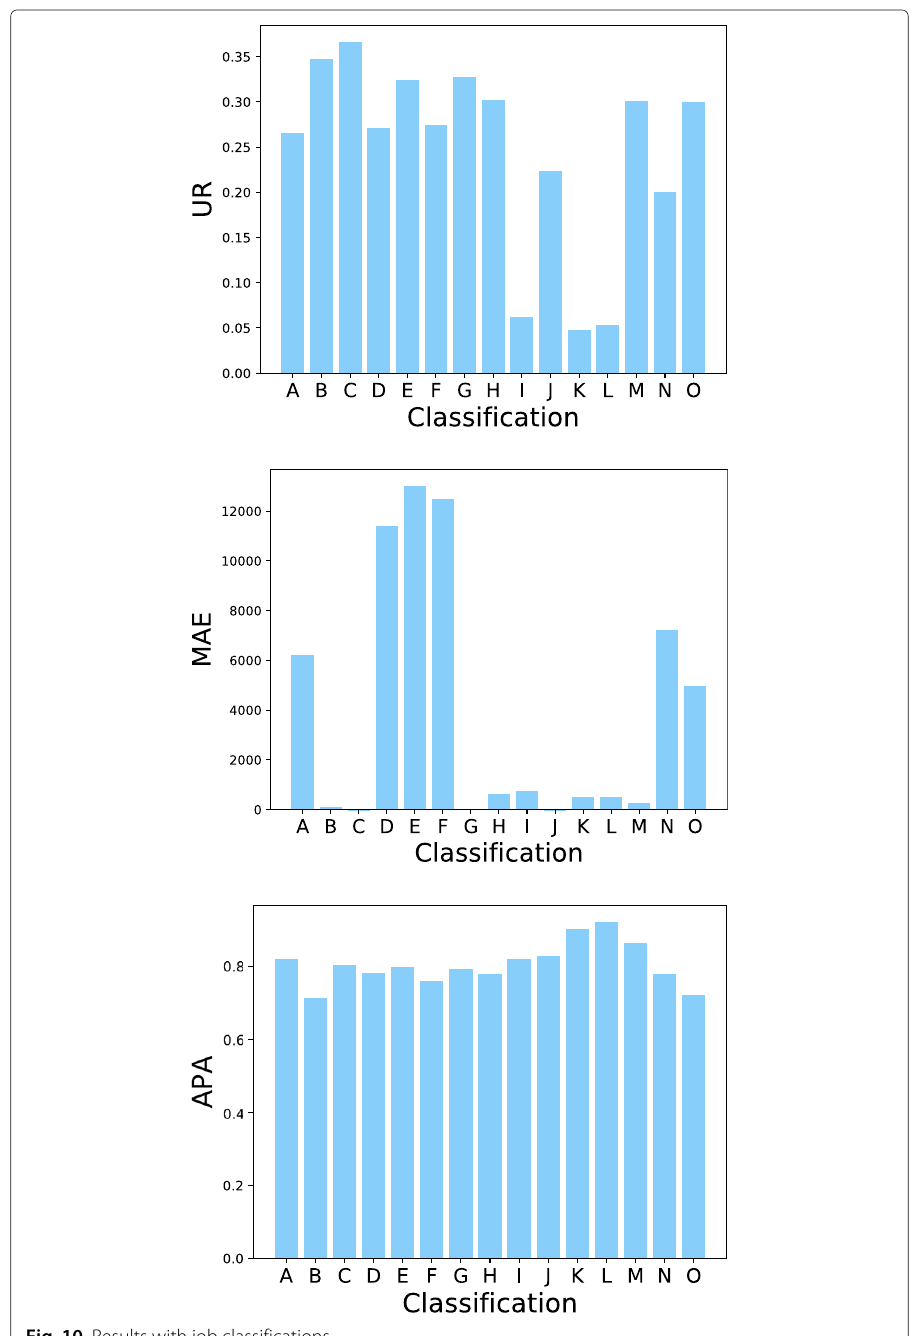
Fig. 10 Results with job